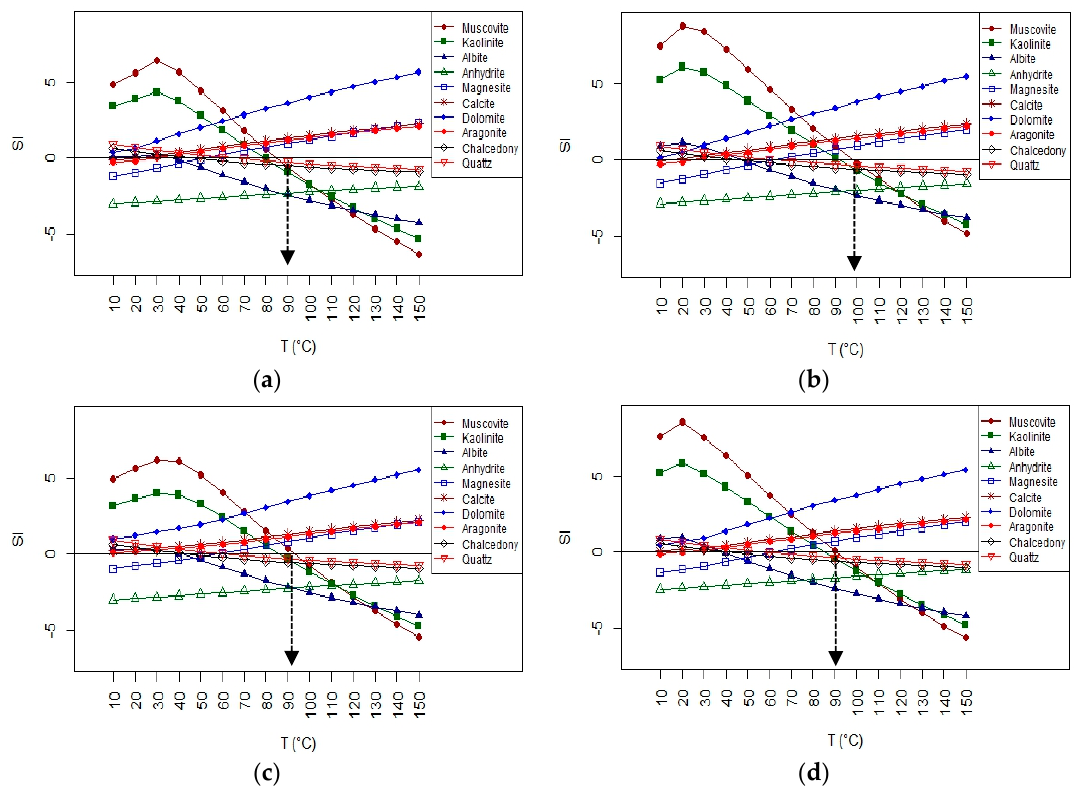
Figure 8. Changes in the saturation indices of selected minerals as a function of temperature: ( a ) Sample 6; ( b ) Sample 8; ( c ) Sample 12 and ( d ) Sample 15.